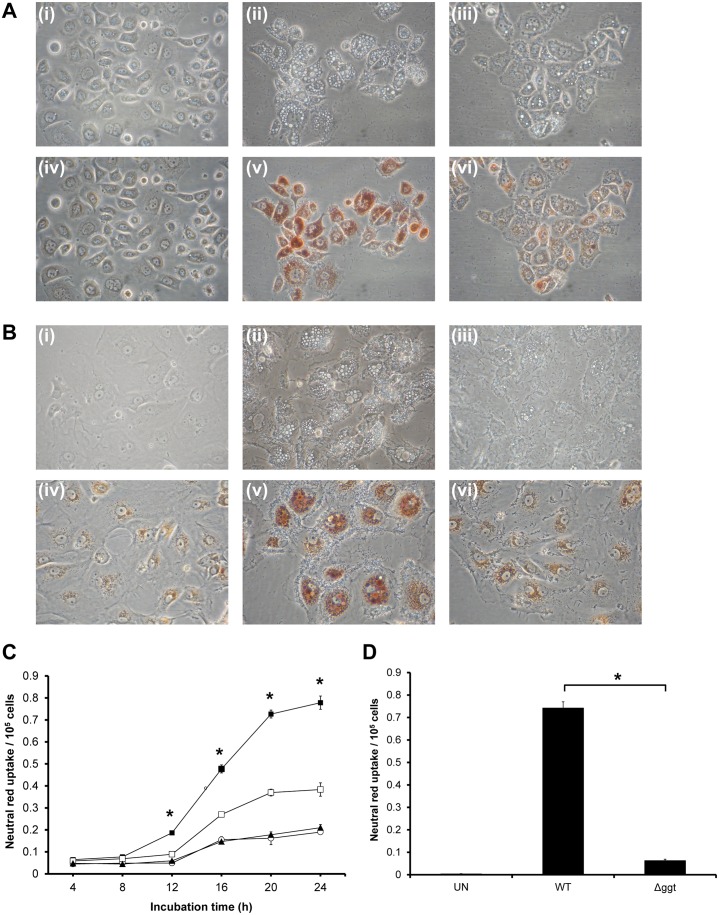
GGT contributes to vacuolation induced by H. pylori.Phase-contrast micrographs of (A) AGS cells and (B) primary gastric epithelial cells before and after neutral red uptake assay following co-culturing at MOI of 1:100 with H. pylori WT or Δggt for 24 hours. Uninfected cells (i), WT-treated cells (ii) or Δggt-treated cells (iii) were observed using phase contrast microscopy. The cells were subjected to neutral red dye assay (iv, v and vi, respectively) and observed under the microscope. Original magnification, ×400. Extent of vacuolation is indicated by the amount of neutral red retained within the cells. (C) AGS cells were co-cultured with WT H. pylori (■) or Δggt (□) at MOI 100 for various time-points up to 24 hours. (▲) indicates uninfected cells. The cells were then subjected to neutral red dye uptake assay. (D) Primary gastric epithelial cells were co-cultured with H. pylori WT or Δggt for 24 hours and subjected to neutral red uptake assay. Experiments were performed in triplicates and values represent the means ± SD from 3 independent experiments. *P<0.05.